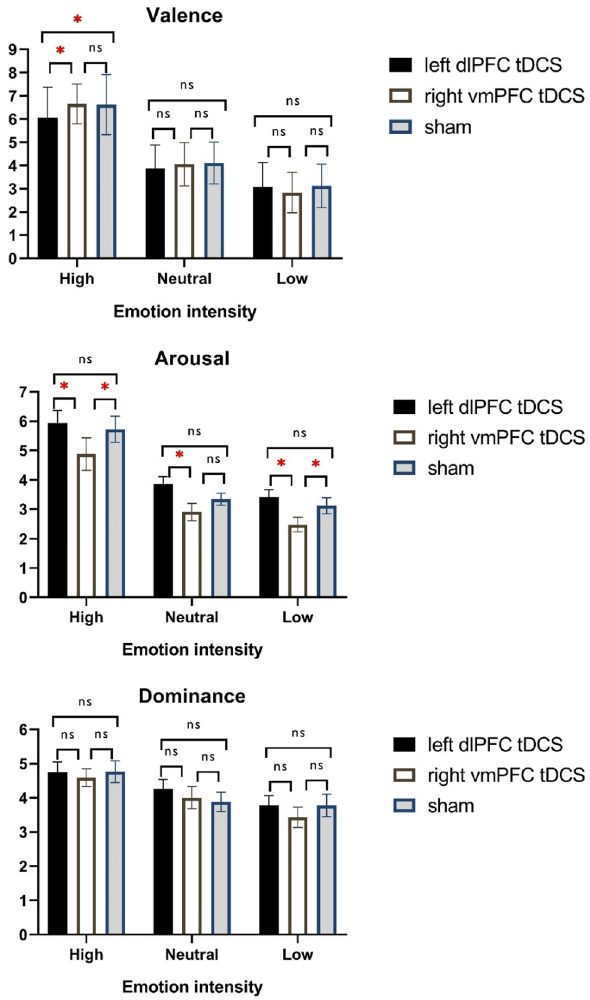
Figure 2. Shown are the effects of tDCS on valence, arousal and dominance of emotion ratings. Note vmPFC = ventromedial prefrontal cortex; dlPFC = dorsolateral prefrontal cortex; ns = non-significant; High emotional intensities represents positive, and low emotional intensities negative emotions for valence. * = indicates significant pairwise comparisons between stimulation conditions based on the results of post-hoc t-tests (paired, p < 0.05) n = 22; all error bars indicate Standerd Error of Mean